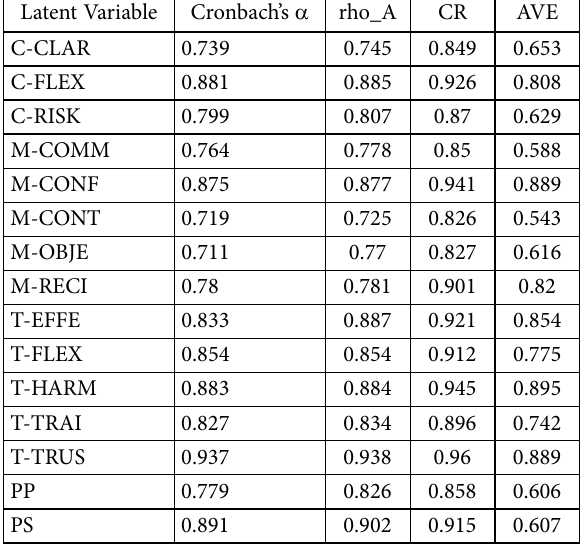
Table 3. Indicators reliability and convergent validity